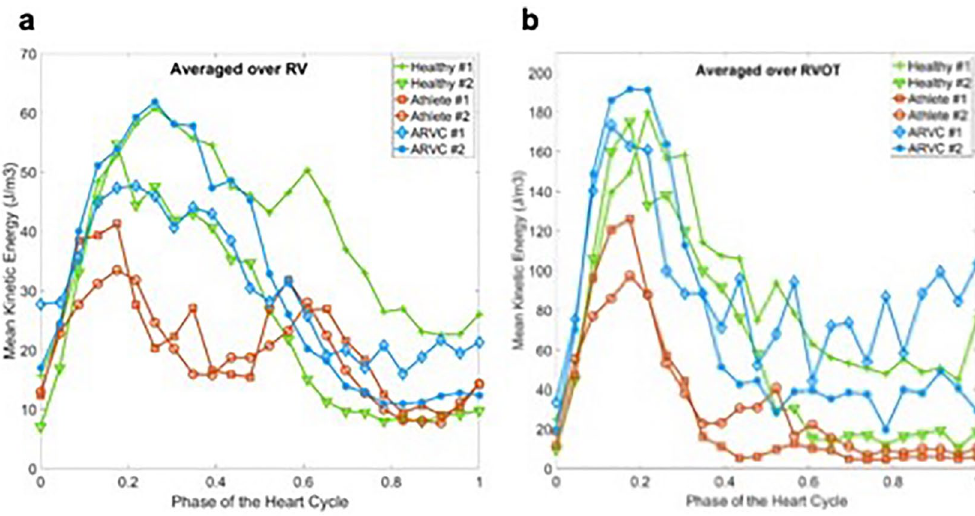
Figure 2. ( a ) Time evolution of mean kinetic energy (MKE) averaged over RV for healthy probands, athletes and patients with ARVC. ( b ) Time evolution of mean kinetic energy (MKE) averaged over RVOT for healthy probands, athletes and patients with ARVC.